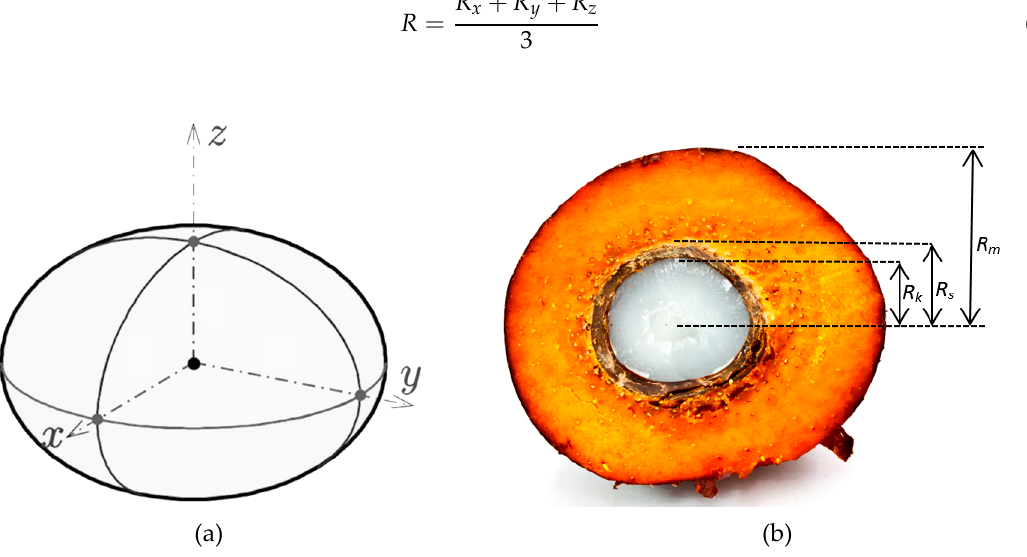
Figure 1. Geometry of oil palm fruit ( a ) Spheroid shape, ( b ) Section to measure mean radius for fruit, endocarp, and kernel.